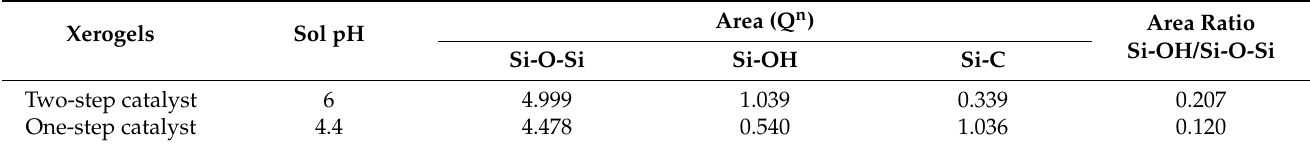
Table 2. Deconvolution of Si-OH/Si-O-Si